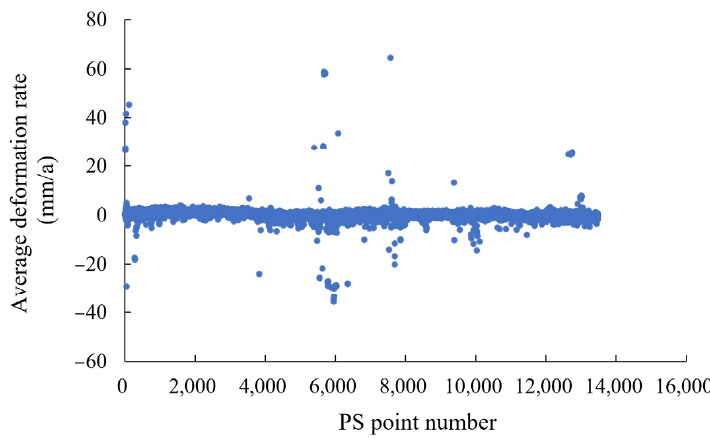
Figure 7. Distribution of the ground point deformation rate in the study area.